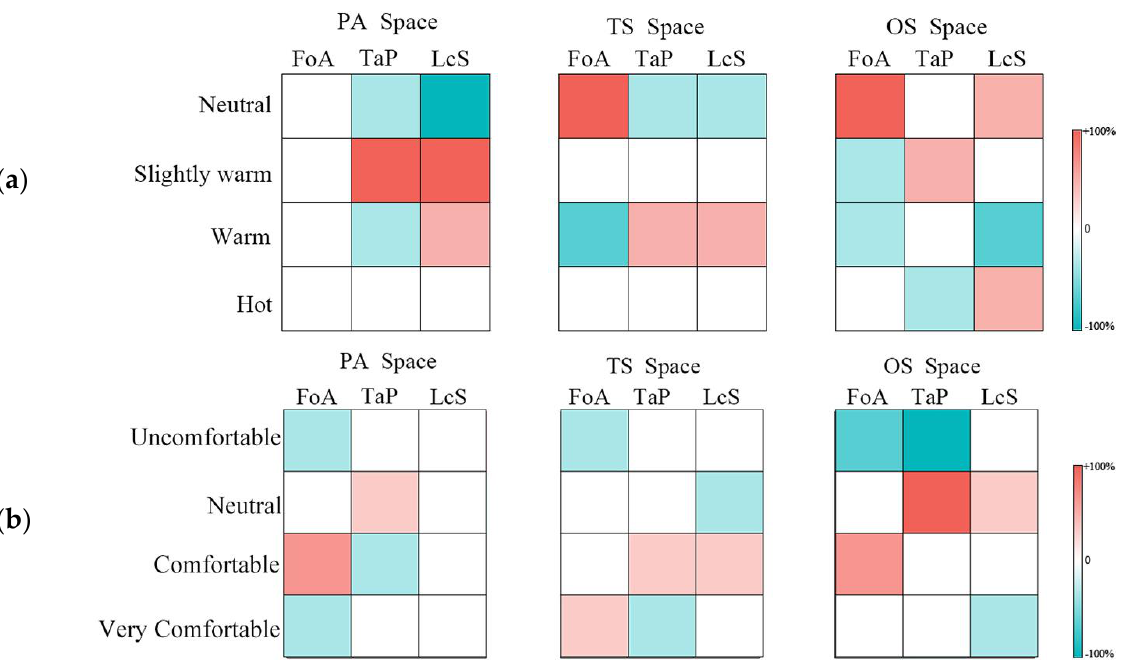
Figure 5. TSV and TCV changes after three space horticultural activities (( a ) TSV and ( b )